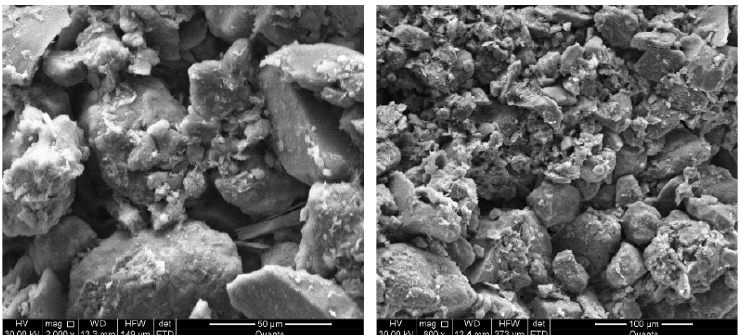
Figure 2. SEM images of Yellow River alluvial silt particles.